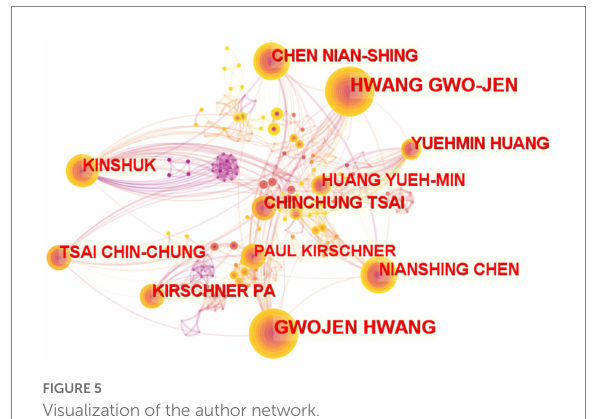
FIGURE 5 Visualization of the author network.